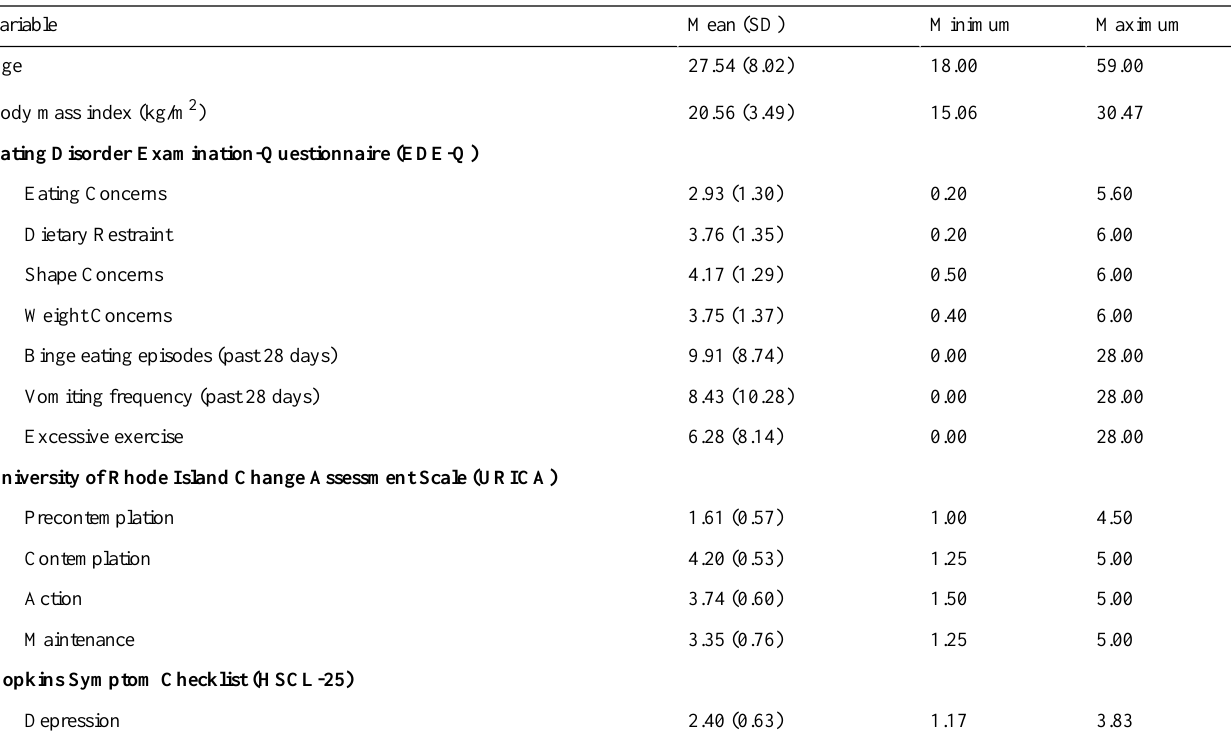
Table 1. Participants’characteristics at